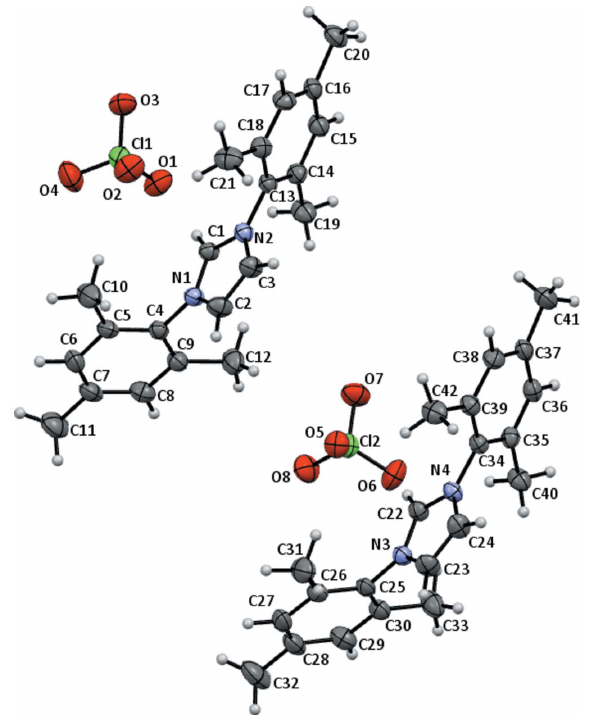
Figure 1 The molecular structure of the title compound with displacement ellipsoids drawn at the 50% probability